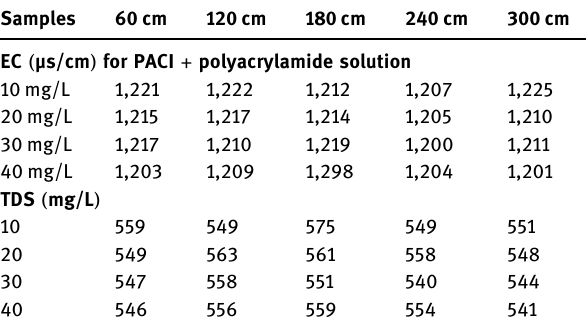
Table 2: The EC and TDS values for polyacrylamide with